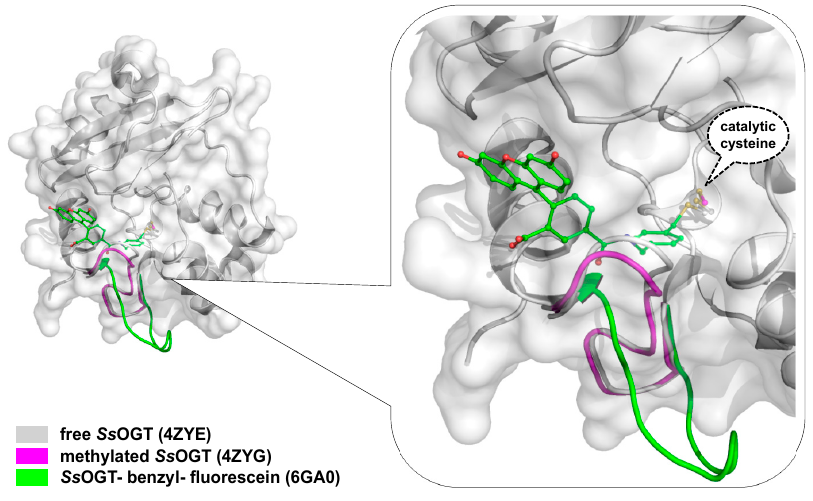
Figure 4. Conformational changes of the Ss OGT active-site loop after reaction with an O 6 -MG dsDNA oligonucleotide (in magenta; [39]), or with SNAP Vista Green substrate (in green;